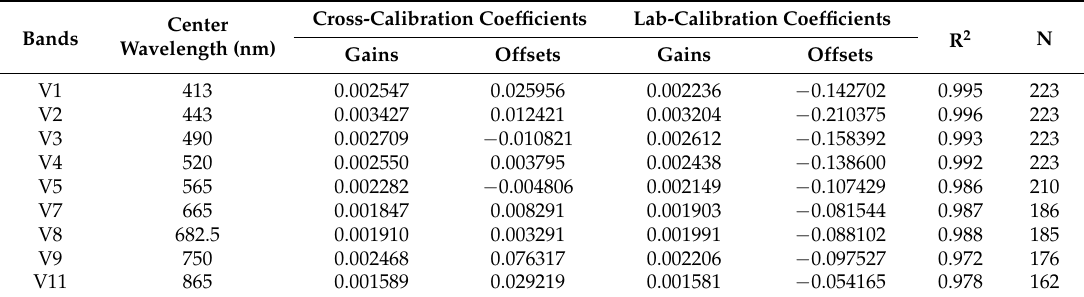
Figure 4. MODIS simulated TOA radiances against the MWI digital numbers (DNs) for the nine spectral bands of MWI. Table 4. Cross-calibration coefficients of the nine bands of TG ‐ 2/MWI.